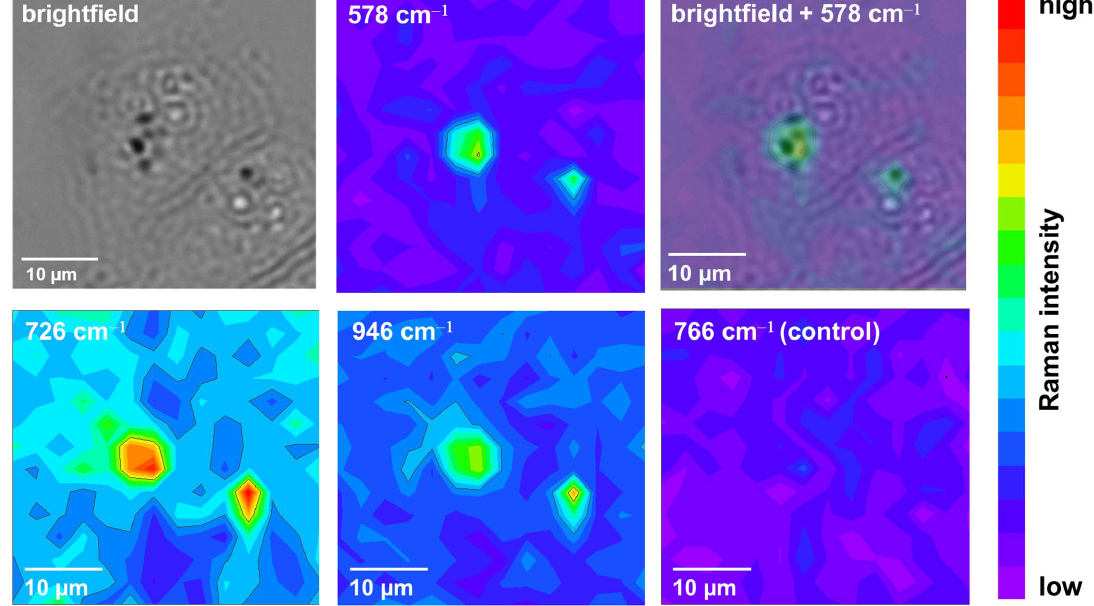
Figure 7. SERS images of two HeLa cells after incubation with nanotags.